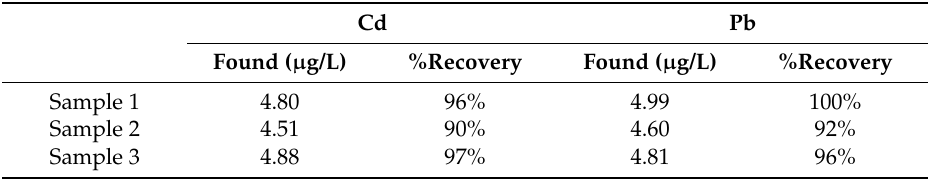
Table 4. Stripping analysis of Cd and Pb under flow-injection analysis differential pulse stripping voltammetry on spiked samples at 5 μ g/L with lead and cadmium.